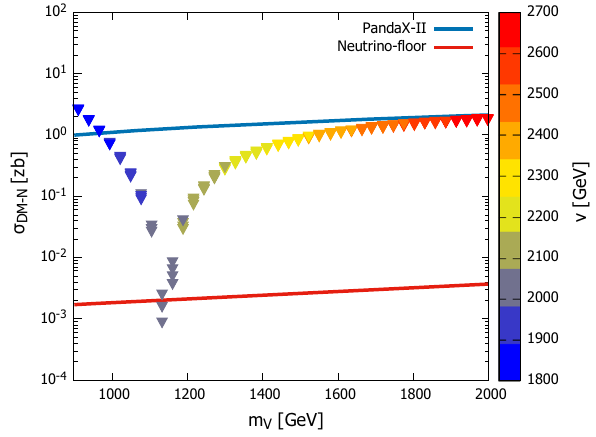
Fig. 1 DM-nucleon cross section for a parameter space already con- strained by DM relic density, (cid:9) h 2 = 0 . 12